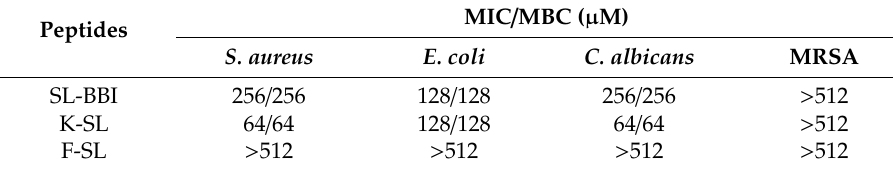
Table 3. Antimicrobial e ff ect of SL-BBI and its analogues against tested microorganisms.